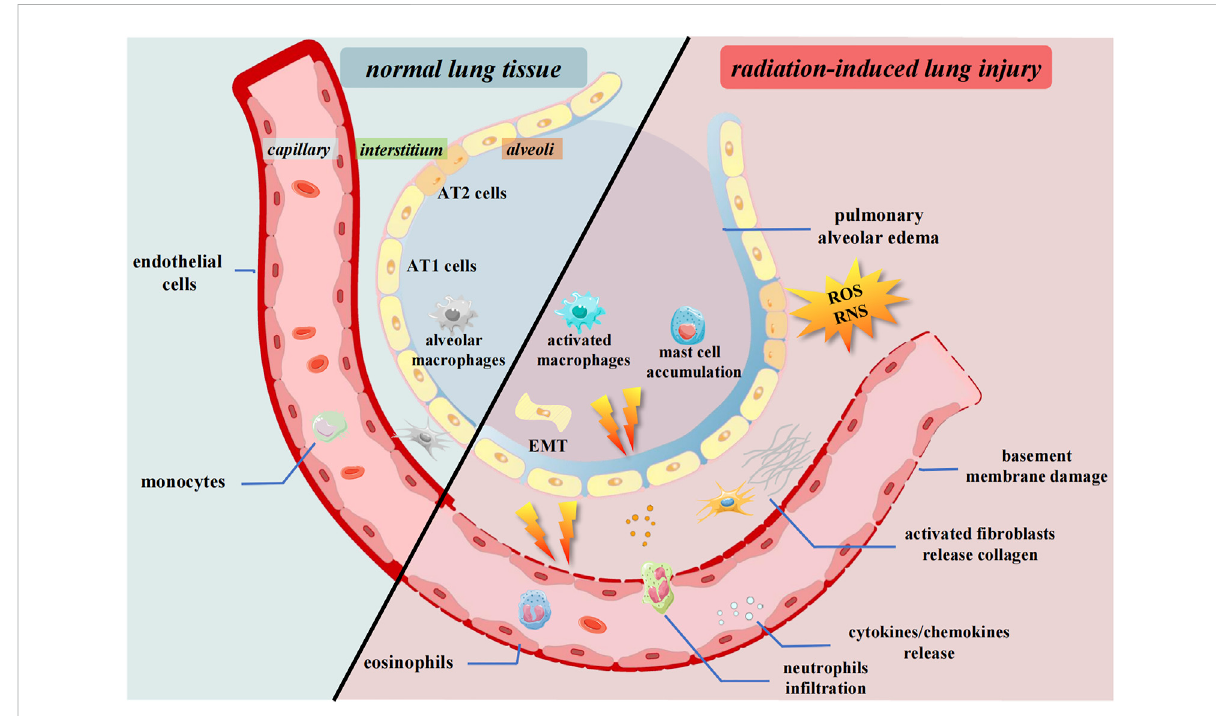
FIGURE 1 Pulmonary tissue changes after irradiation. Radiation causes the release of cytokines and chemokines. The in fl ammatory cells and fi brosis associated cells are activated and in fi ltrate to interstitium. ROS and RNS accumulate in the microenvironment. The epithelium undergoes EMT process. AT1 cells, Alveolar type 1 cells; AT2 cells, Alveolar type 2 cells; ROS, Reactive oxygen species; RNS, Reactive nitrogen species; EMT, Epithelial-mesenchymal